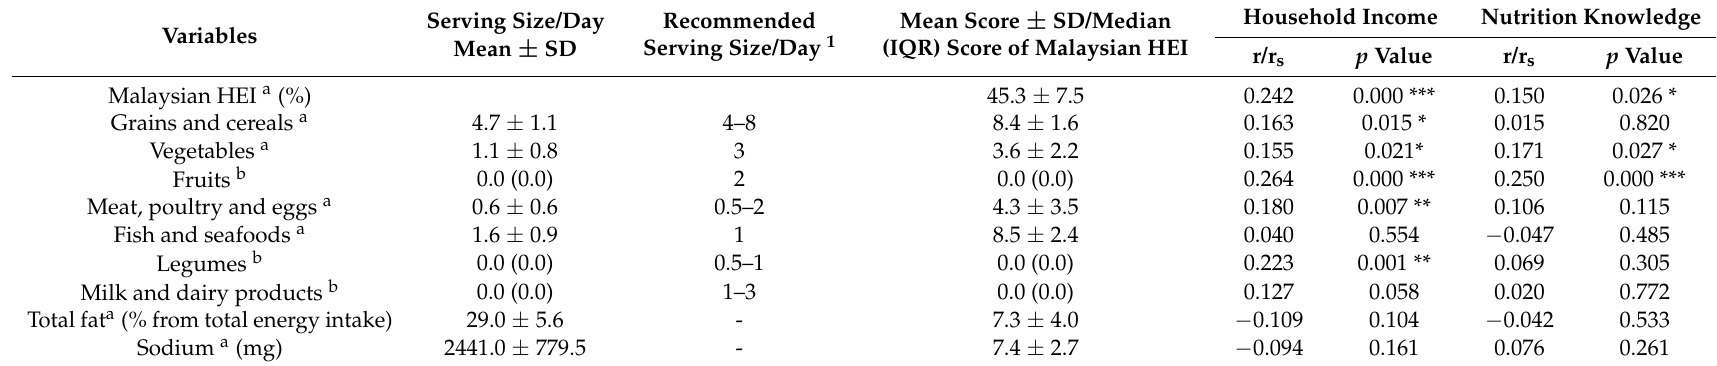
Table 5. Household income and nutrition knowledge correlated with component scores of Malaysian Healthy Eating Index